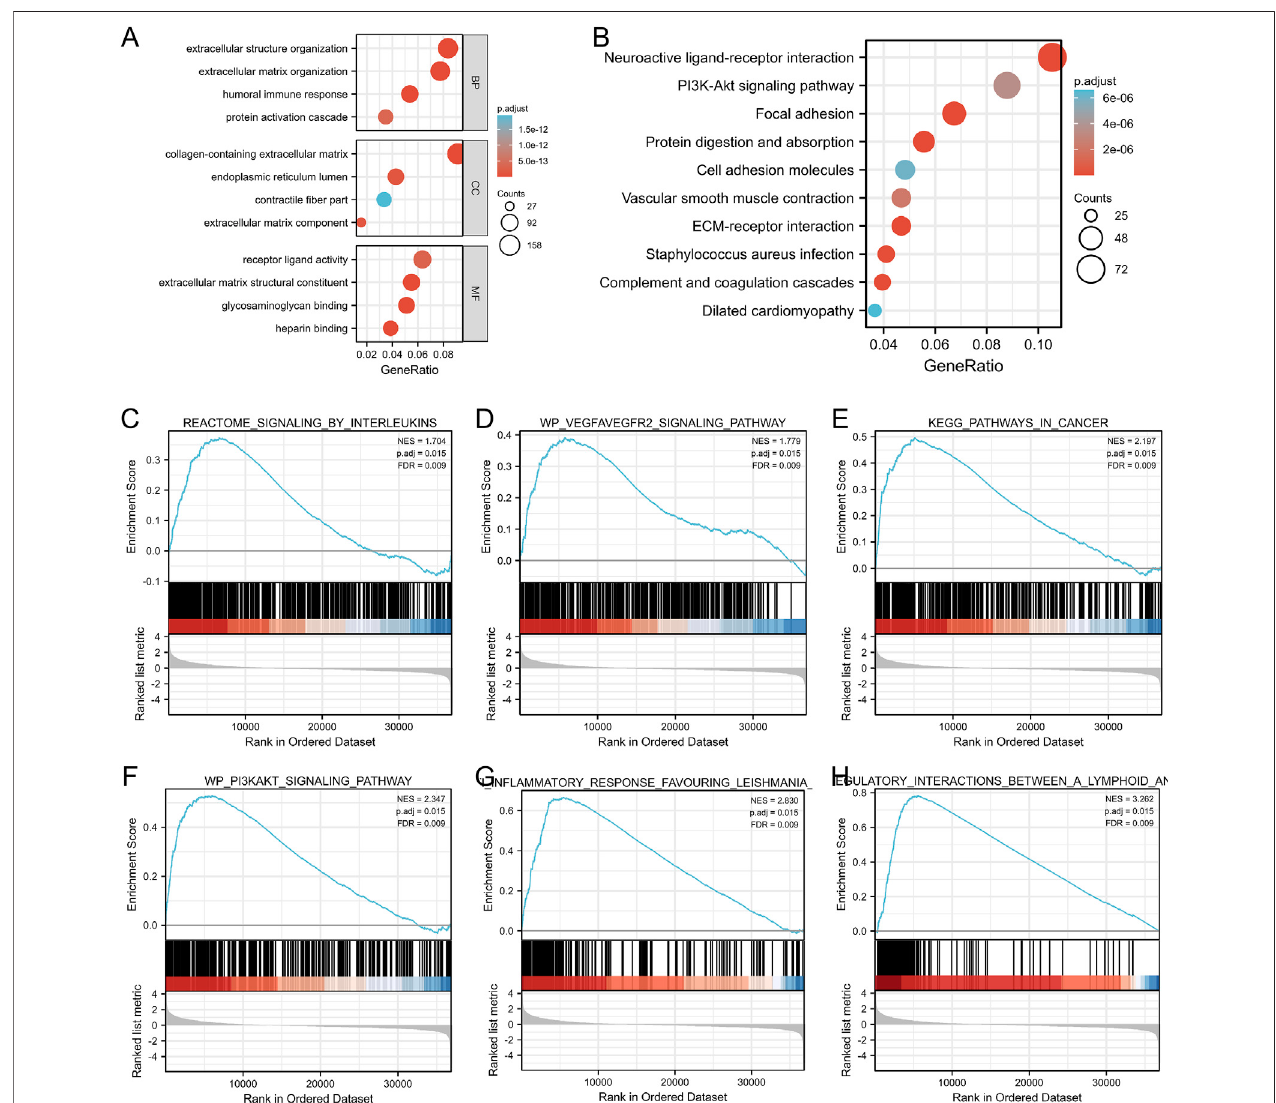
FIGURE 7 | GO categories and pathway enrichment analysis of GGT5 in gastric cancer. (A) GO annotations of DEGs. (B) KEGG pathway enrichment analysis determined the top 10 signi fi cantly enriched pathways. (C – H) GSEA was applied to identify GGT5 -relevant signaling pathways and biological processes including signaling by interleukins, the VEGFA-VEGF2 signaling pathway, pathways in cancers, the PI3K/Akt signaling pathway, anti-in fl ammatory response favoring Leishmania, and immunoregulatory interactions between lymphoid and non-lymphoid cells. NES: normalized enrichment score; p . adj: adjusted p value ; FDR: false discovery